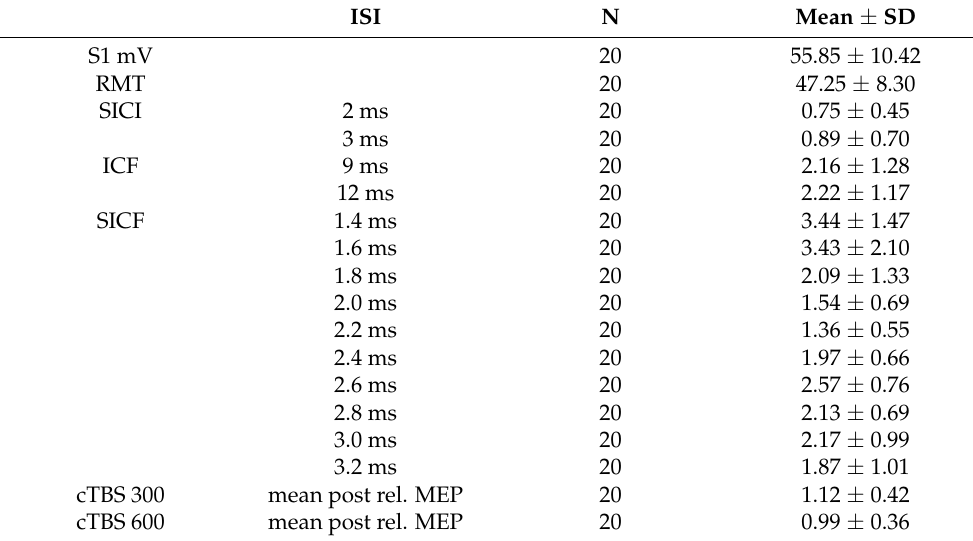
Table 2. Descriptive statistics of baseline excitability measures (Experiment 1: S1 mV, RMT, SICI, ICF, SICF) and for relative mean post stimulation MEP magnitudes of Experiment 2 (cTBS 300)